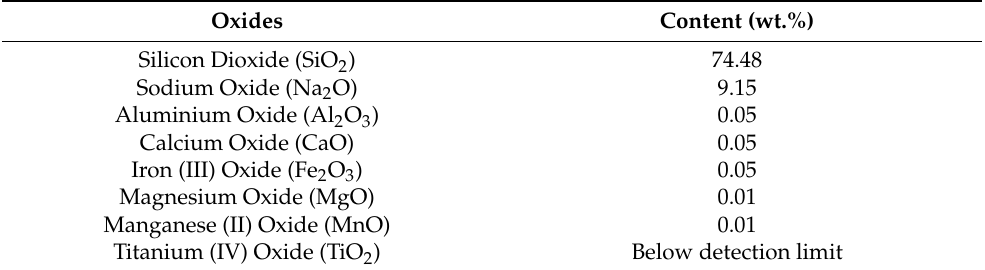
Table 2. Composition of the silica aerogel sample obtained from the X-Ray Fluorescence (XRF) anal- ysis.